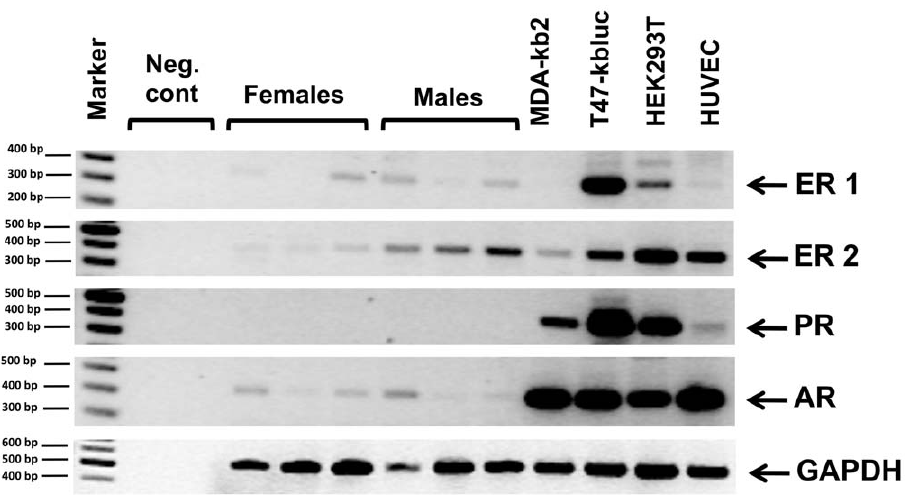
Figure 2. RT-PCR of the receptors in MDA-Kb2, T47-Kbluc, HEK293T, HUVEC cells and male and female peripheral blood derived cells. Estrogen Receptor 1 (ER-1 (alpha)), Estrogen Receptor 2 (ER-2 (beta)), Progesteron Receptor (PR), and Androgen receptor (AR).